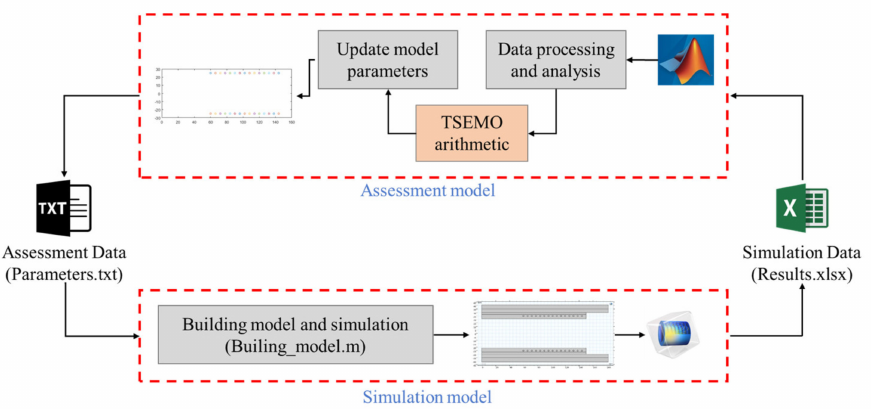
Figure 8. The structure of automation optimization process.